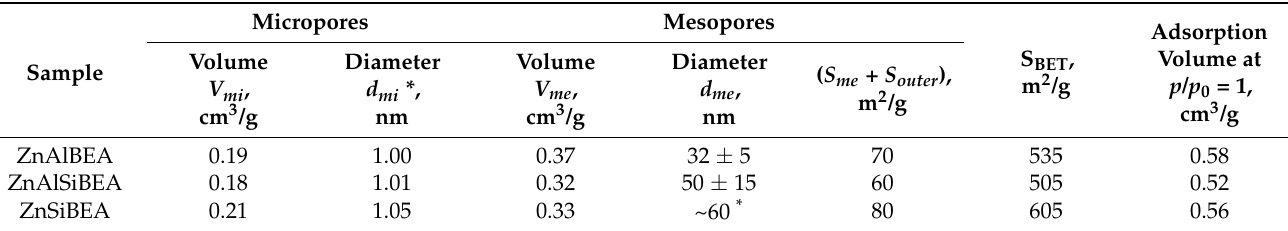
Table 1. Texture characteristics of zeolite Zn-BEA samples.